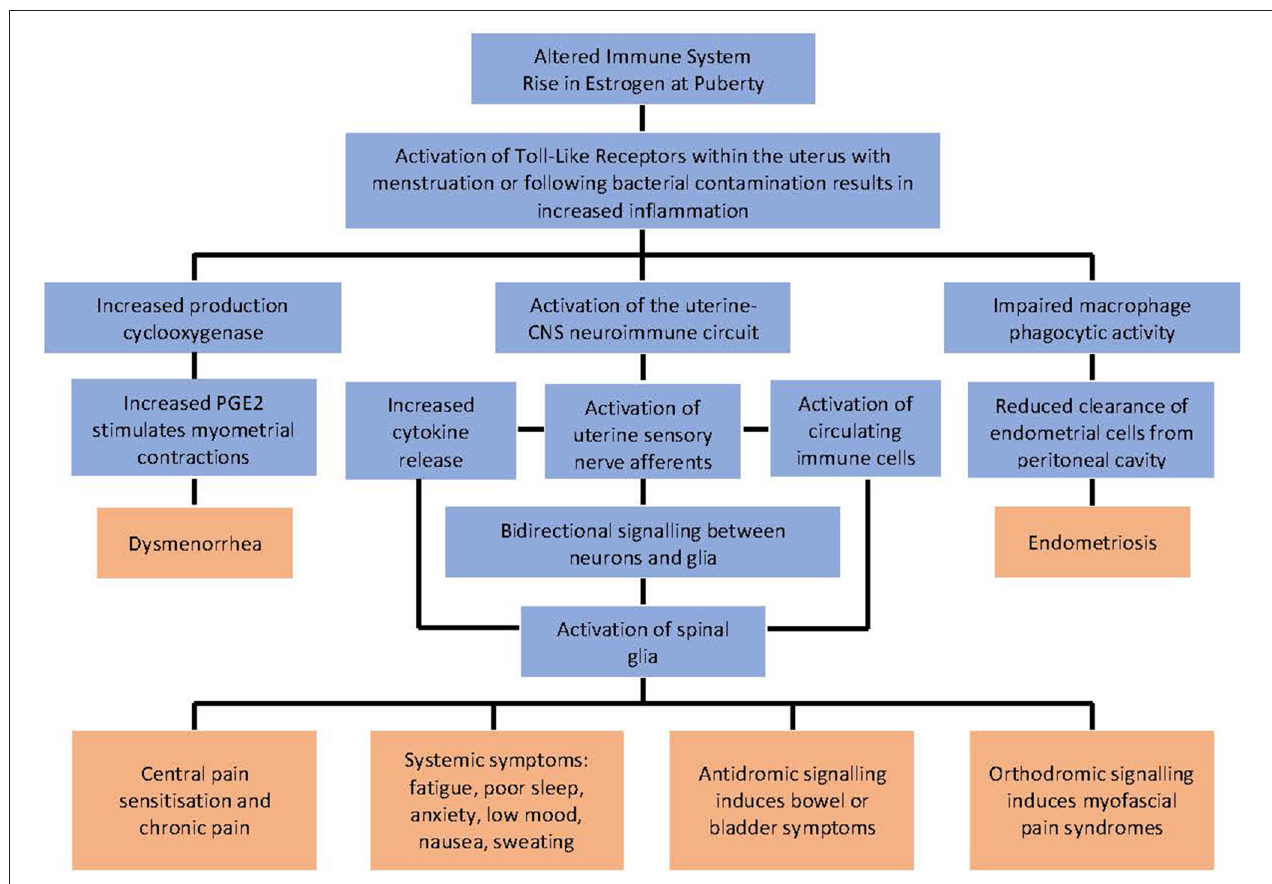
FIGURE 1 | The relationship between inflammation, dysmenorrhea, endometriosis, the uterine-CNS neuroimmune circuit and their associated symptoms. Adapted with permission from Evans (29). Dissertation. Investigations into the lived experience and etiology of dysmenorrhoea and pelvic pain in young women